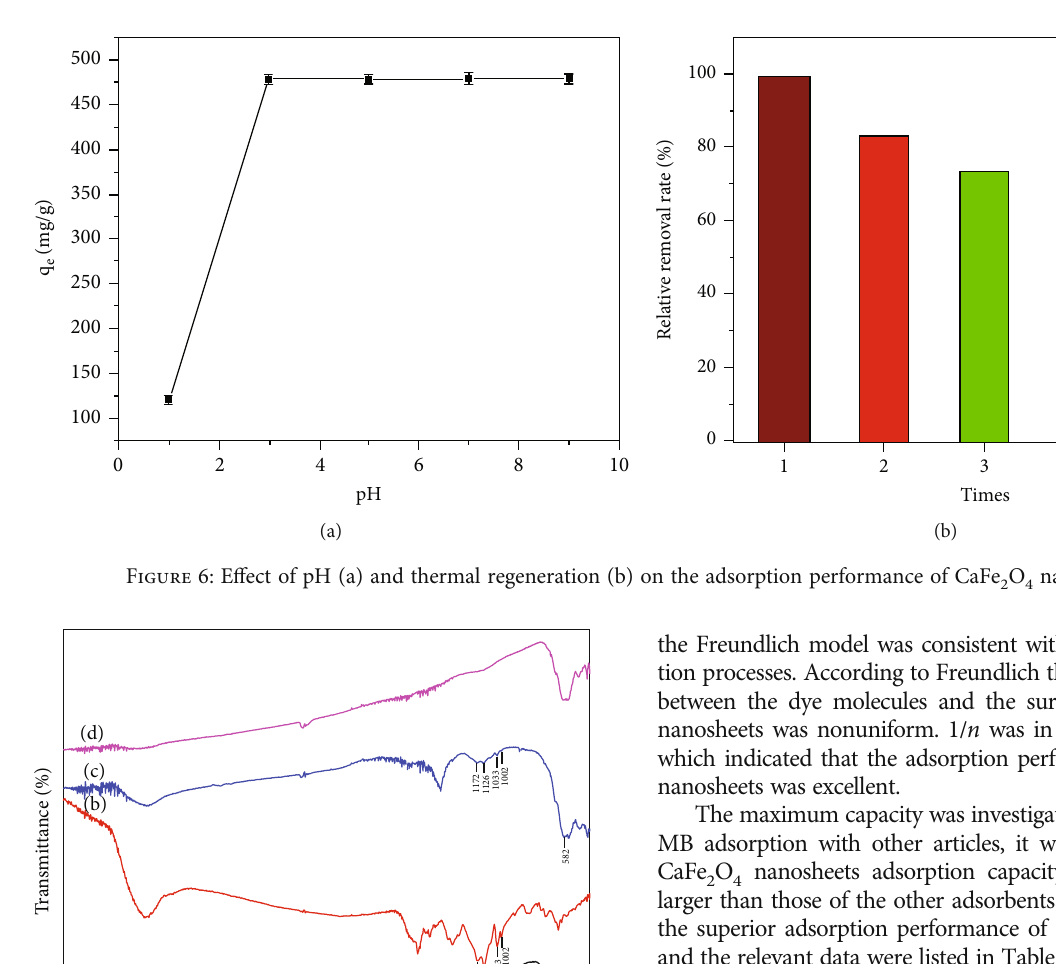
O nanosheets (a), MB (b), 2 4